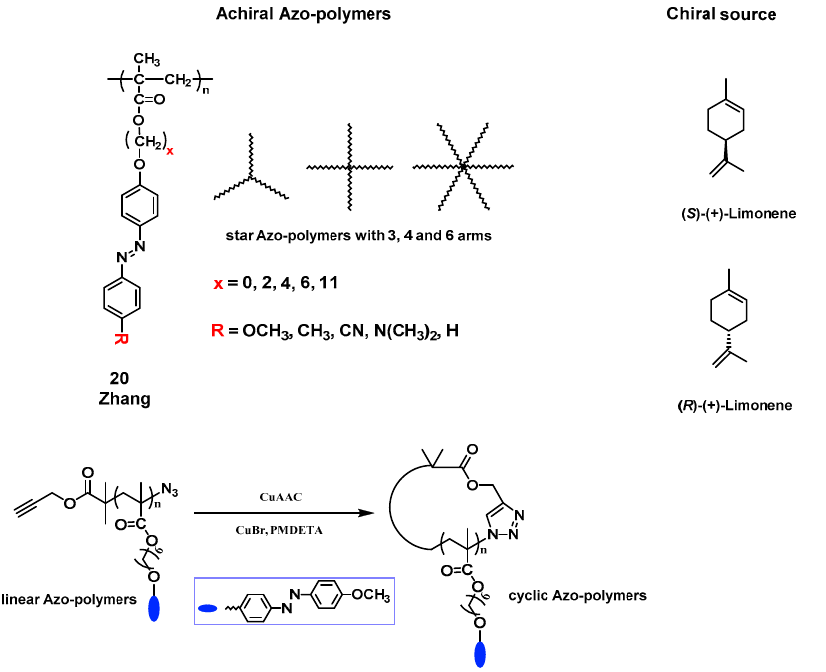
Figure 9. The chemical structures of achiral Azo-polymers based on Azo-polymer 20 and chiral limonene. (x represents different spacer lengths; R represents different substituents).